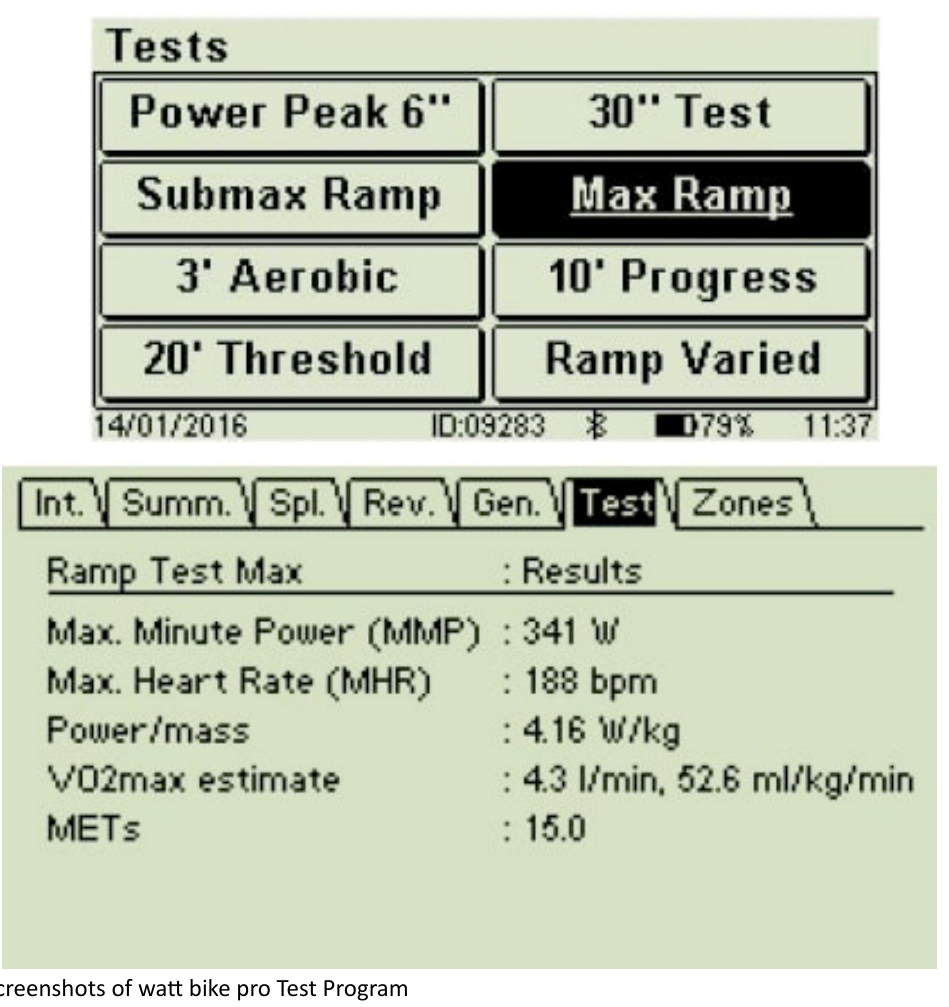
Figure. 1. Screenshots of watt bike pro Test Table 1. Initial Watt Value